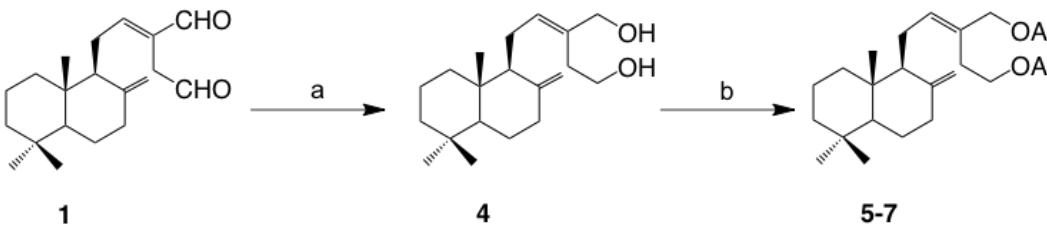
Molecules 2019 , 24 , x FOR PEER Figure 3. Natural terpenes from mango ginger and polygodial. Figure 3. Natural terpenes from mango ginger and polygodial.